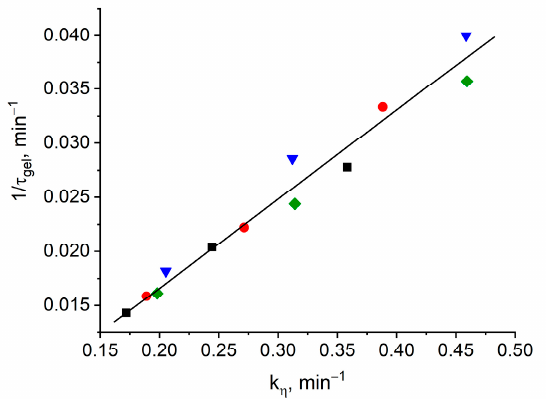
Figure 3. Dependence of the inverse gel time ( τ gel − 1 ) on the viscosity increase rate constant (k η ) for formulation 1 (square), 2 (circle), 3 (triangle), 4 (rhomb).